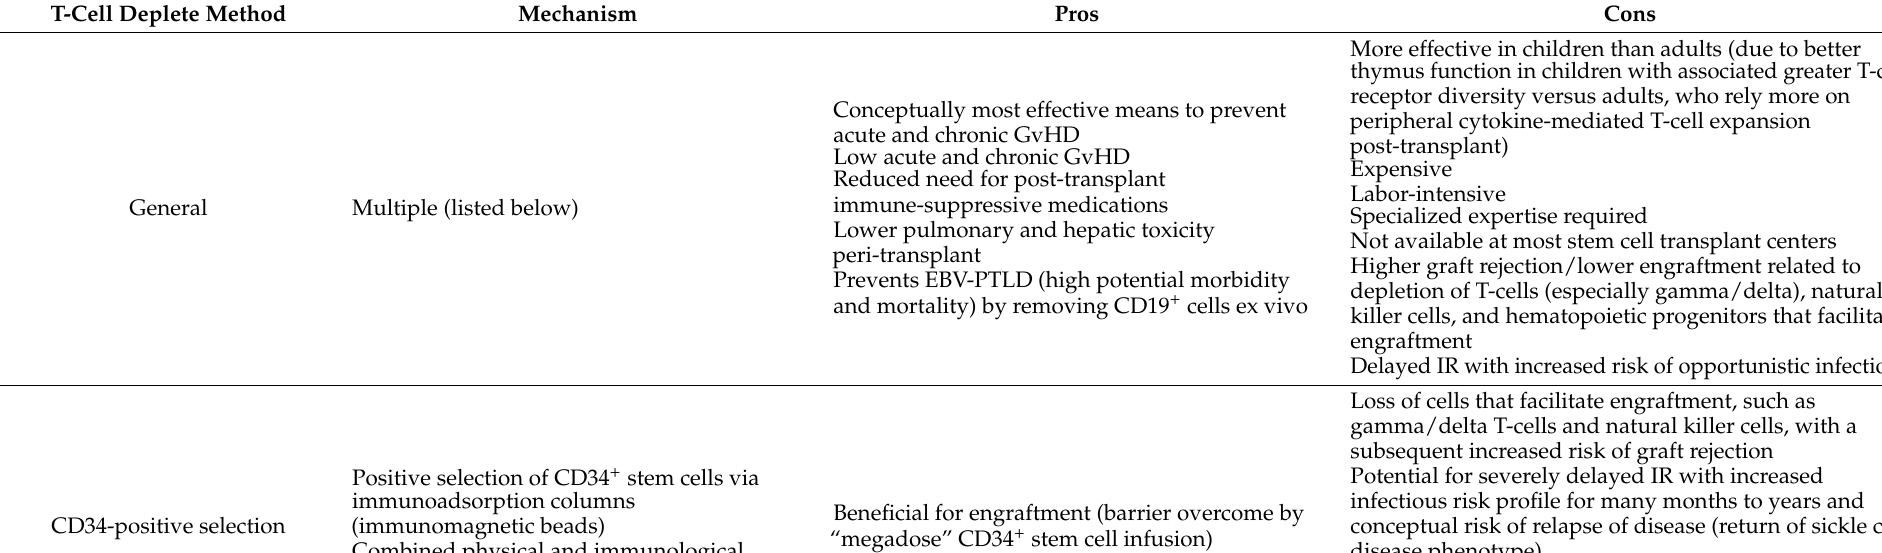
Table 1. Pros and cons of commonly used TCD vs. TCR approaches used in